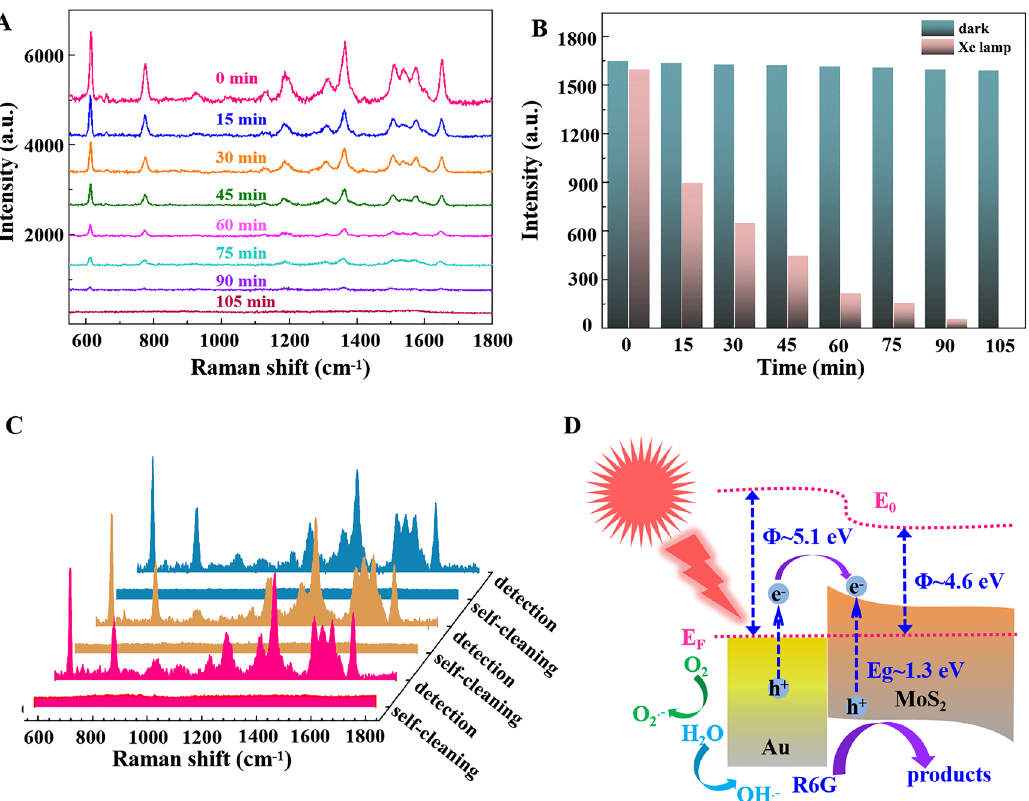
Figure 7: Photodegradation and self-cleaning property. (A)Surface-enhancedRamanspectroscopy(SERS)spectraof R6GforthepyramidSi(PSi)/molybdenumdisulfide(MoS 2 )/Aumultiscalecavity(MSC) irradiatedbyvisiblelightwithanintervalof15min.(B)Theintensityof613cm − 1 fromthesubstrateunderirradiationanddarkwithanintervalof15min. (C)RecycledetectionofR6GonthePSi/MoS 2 /AuMSC.(D)IllustrationofthemechanismofphotocatalyticdegradationofR6GoverPSi/MoS 2